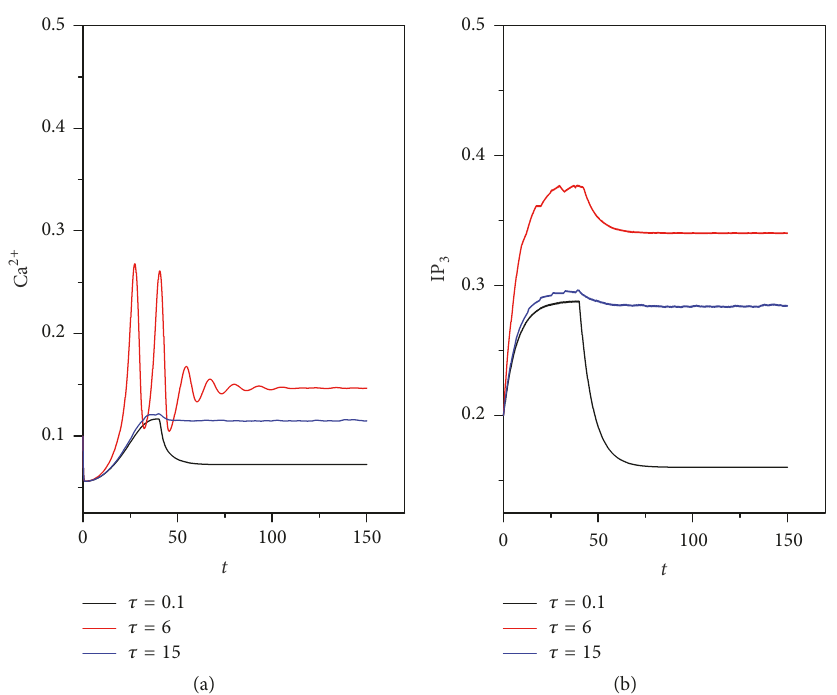
Figure 12: Fluctuation in Ca 2+ concentration (a) and IP 3 concentration (b) is calculated by applying different time delays in autapse with feedback gain 𝑔 𝑒 = −0.5 . The parameter is set as 𝑟 IP 10.0 𝜇 mol/L ⋅ cm 2 at 𝑡 < 40